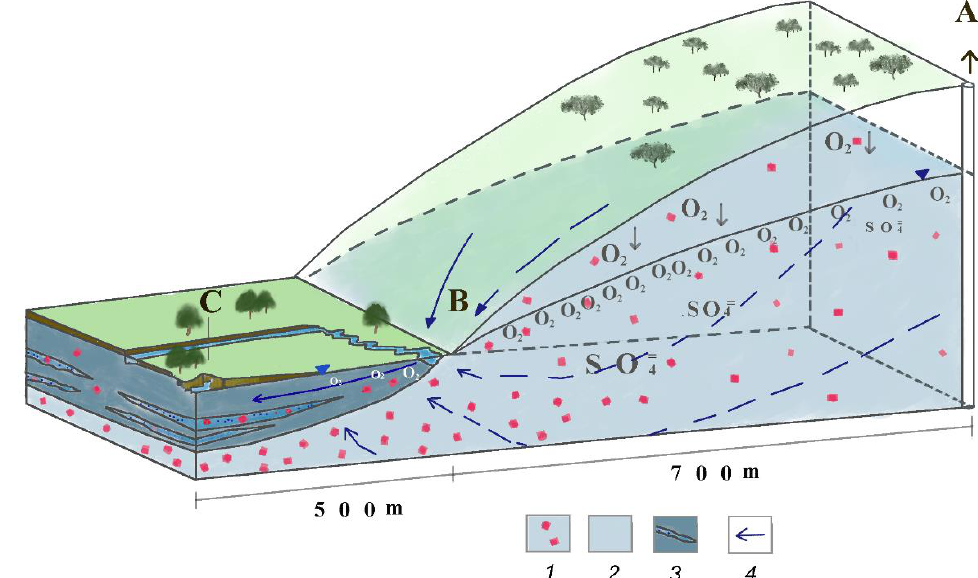
Figure 9. Hydrogeochemical model represented in diagrammatic sections along A–B–C flow line (Figure 3B) (A–B in the calcareous aquifer, and B–C in the quaternary aquifer with organic sediments).